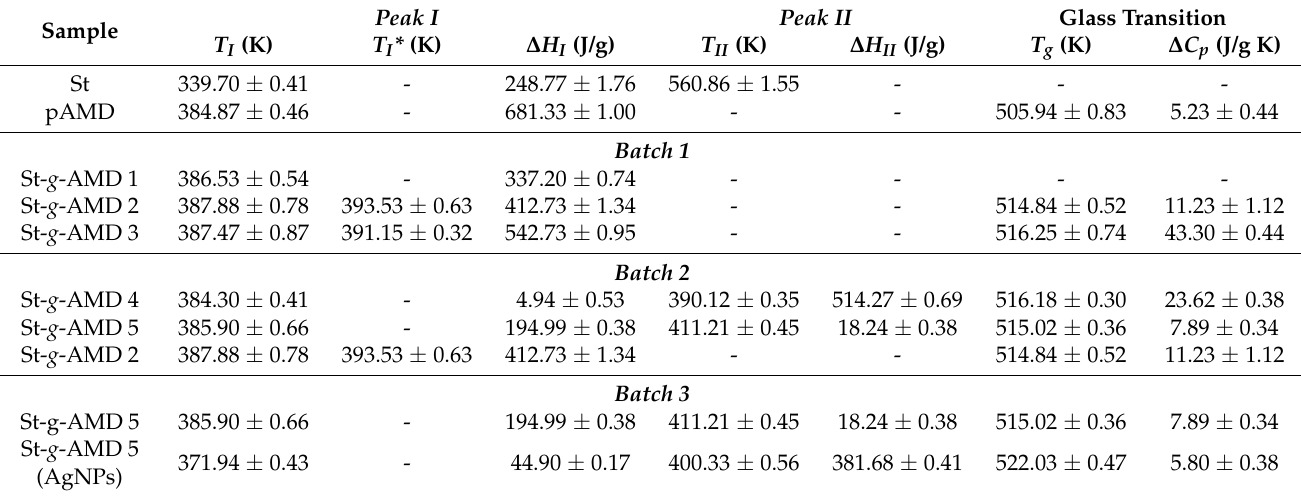
Figure 1. DSC curves of St, pAMD, and graft copolymers synthesized: ( a ) with the same (cid:1830)(cid:4662) and different (cid:1830) ( Batch 1 ), ( b ) with the same (cid:1830) and different (cid:1830)(cid:4662) ( Batch 2 ), and ( c ) with and without AgNPs ( Batch 3 ). Table 4. Thermodynamic parameters of graft